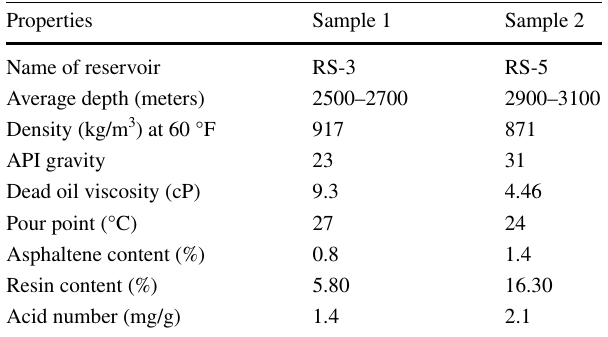
Table 1 Properties of crude oil samples collected from Assam